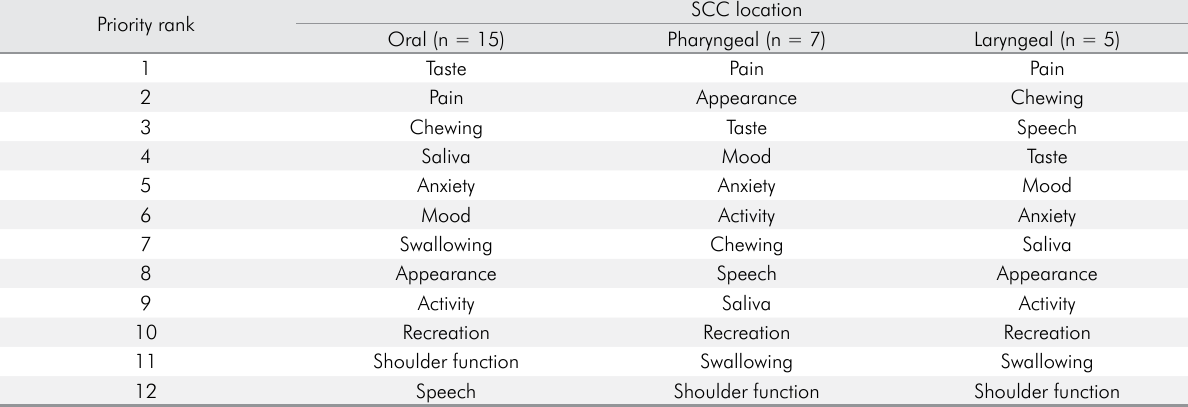
Table 5. Ranking of patient priorities according to tumor location. Priority